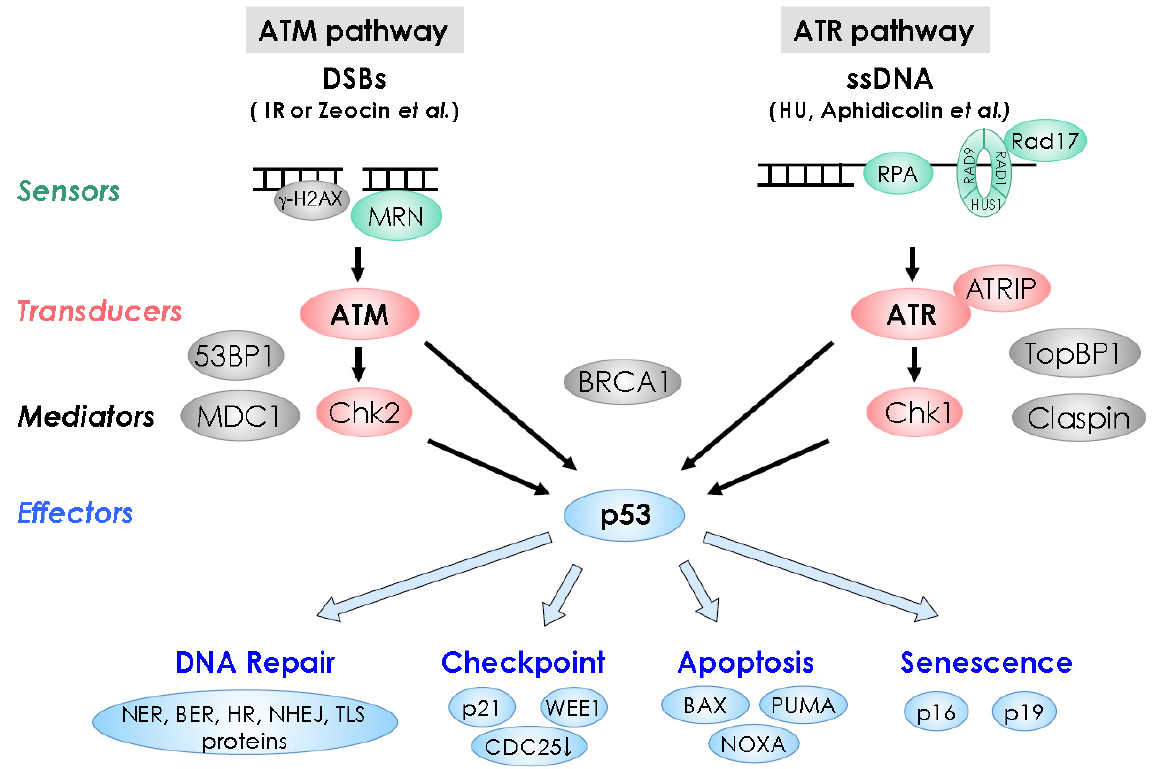
Figure 1. DNA damage response pathways in animals. Double-strand DNA break (DSB) and single-stranded DNA signal through the sensors shown in green, signal transducing kinases shown in red, mediators shown in gray, and effectors shown in blue, leading to DNA repair, cell-cycle checkpoint, apoptosis, or